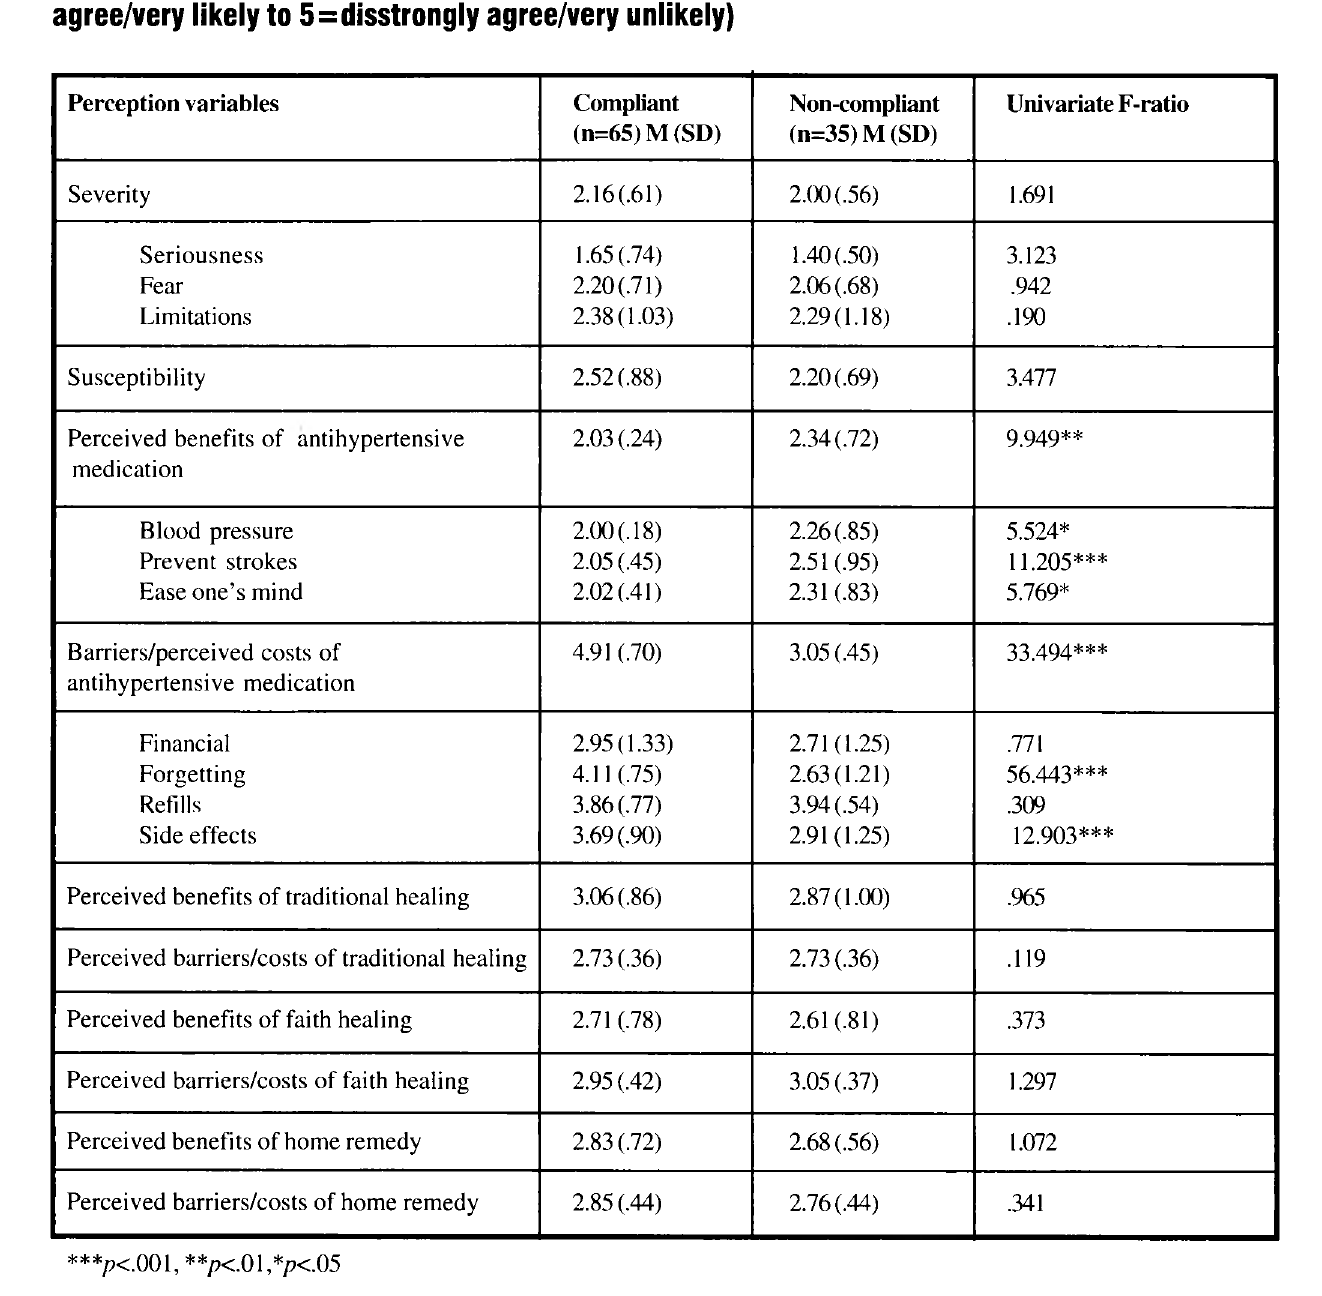
Table 4: Means and standard deviations of study variables of the Health Belief Model (1 = strongly agree/very likely to 5=disstrongly agree/very